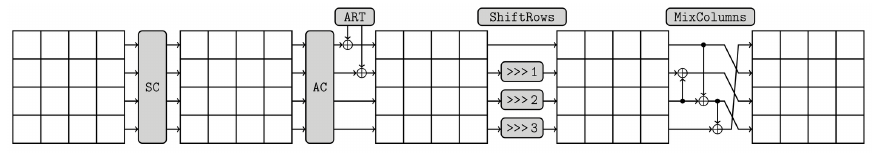
Figure 2: Round function of SKINNY [BJK +